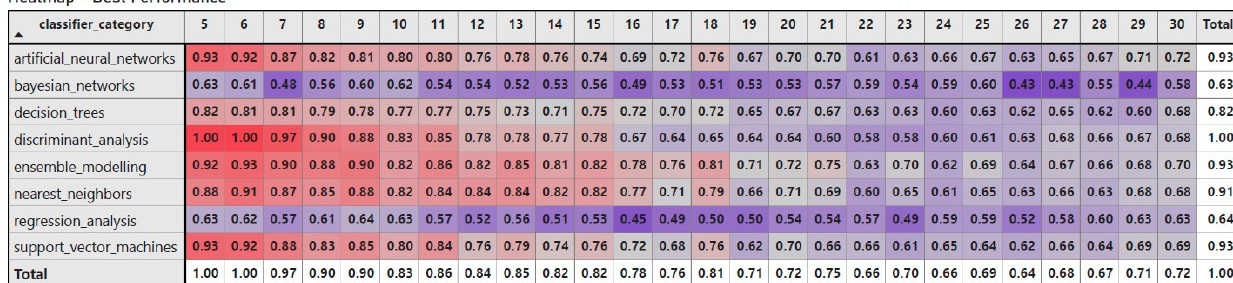
Figure 6. Heatmap presenting the best achieved performance for each classification algorithm and each stress incidence threshold. The bottom row presents the highest performance for the respective incidence threshold, while the last column displays the highest performance.